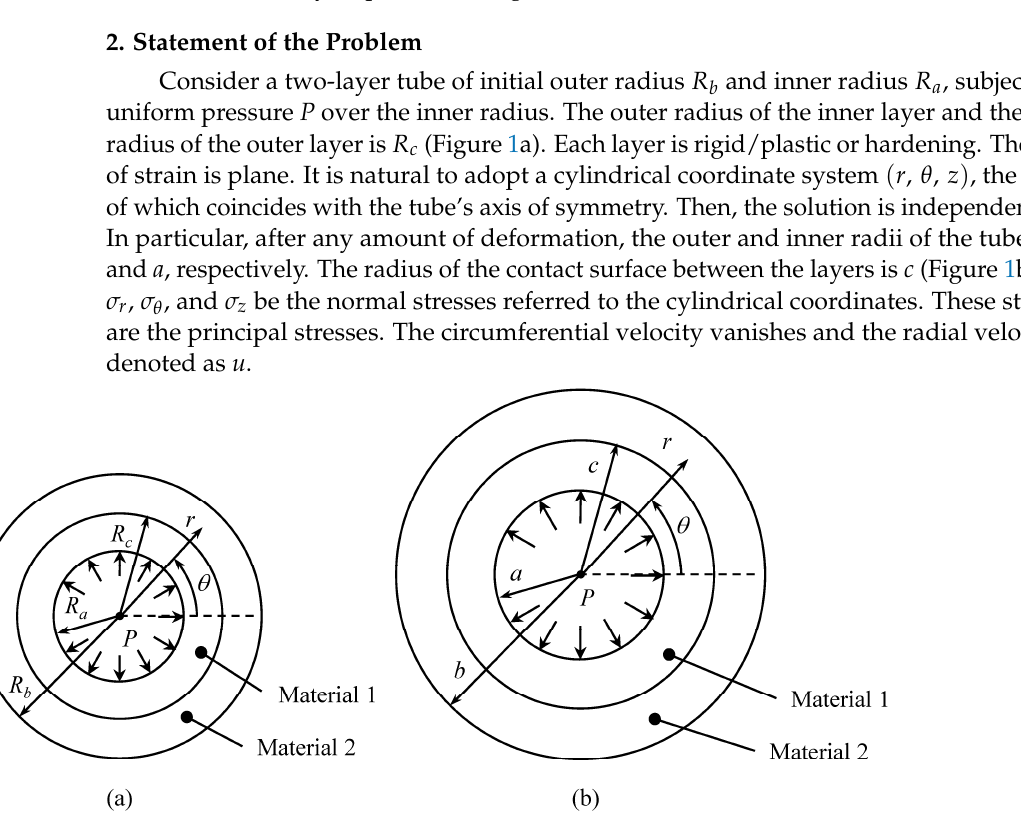
Figure 1. Schematic diagram of the process: ( a ) initial configuration, ( b ) intermediate and final configurations.